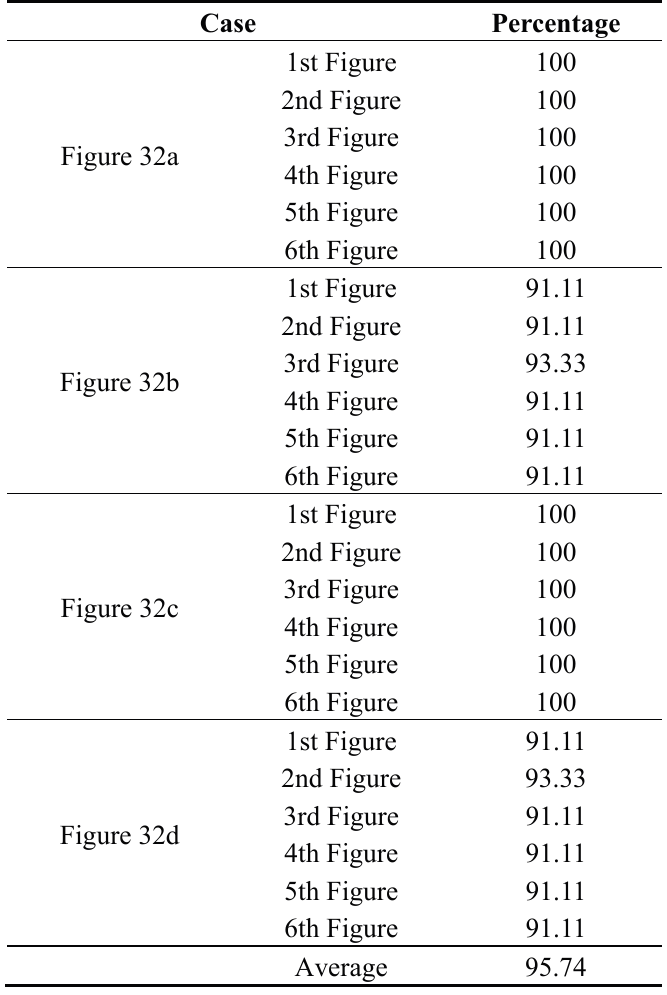
Table 5. The percentage of correctly labeled image of genuine SR versus total number of image in case of head rotations and translations (unit: